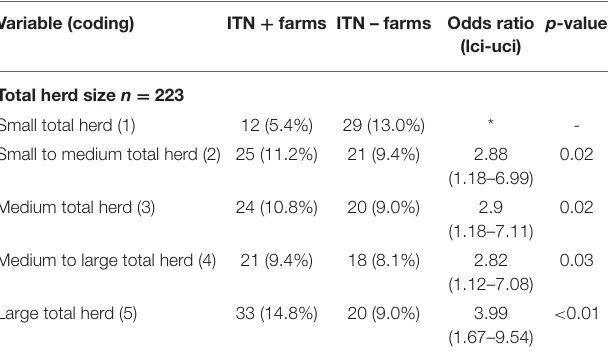
TABLE 3 | The final multivariable model with the reported presence of ischaemic teat necrosis (ITN) on the farm as the outcome variable. Variable